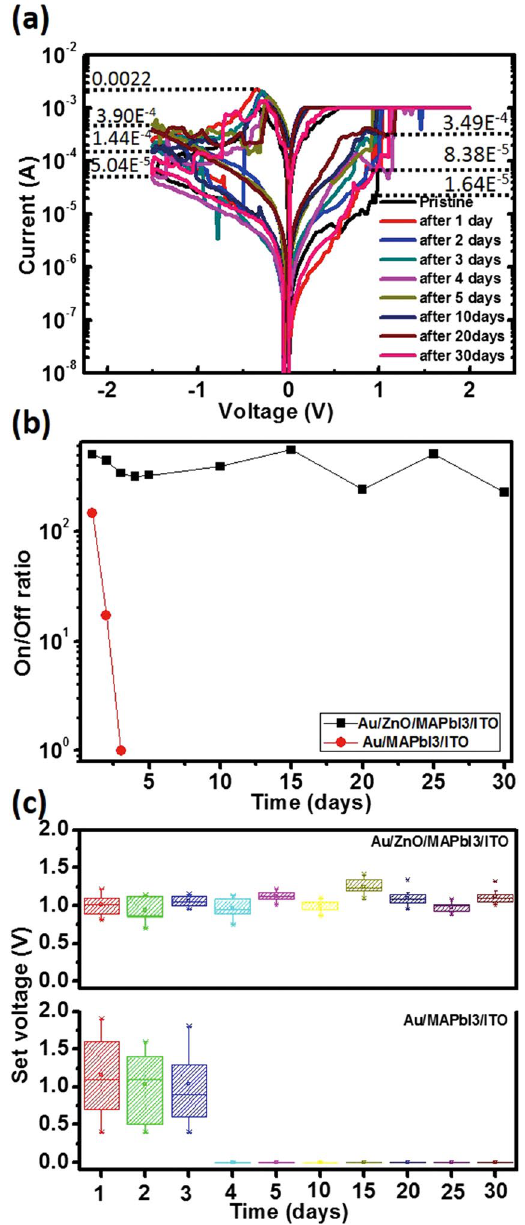
Figure 3. ( a ) Stable resistive switching behavior of Au/ZnO/CH 3 NH 3 PbI 3 /ITO/glass devices irrespective of storage time in an ambient atmosphere without encapsulation. ( b ) On/Off ratio and ( c ) statistical distribution of set voltages of Au/ZnO/CH 3 NH 3 PbI 3 /ITO glass and Au/CH 3 NH 3 PbI 3 /ITO devices vs. storage time in ambient